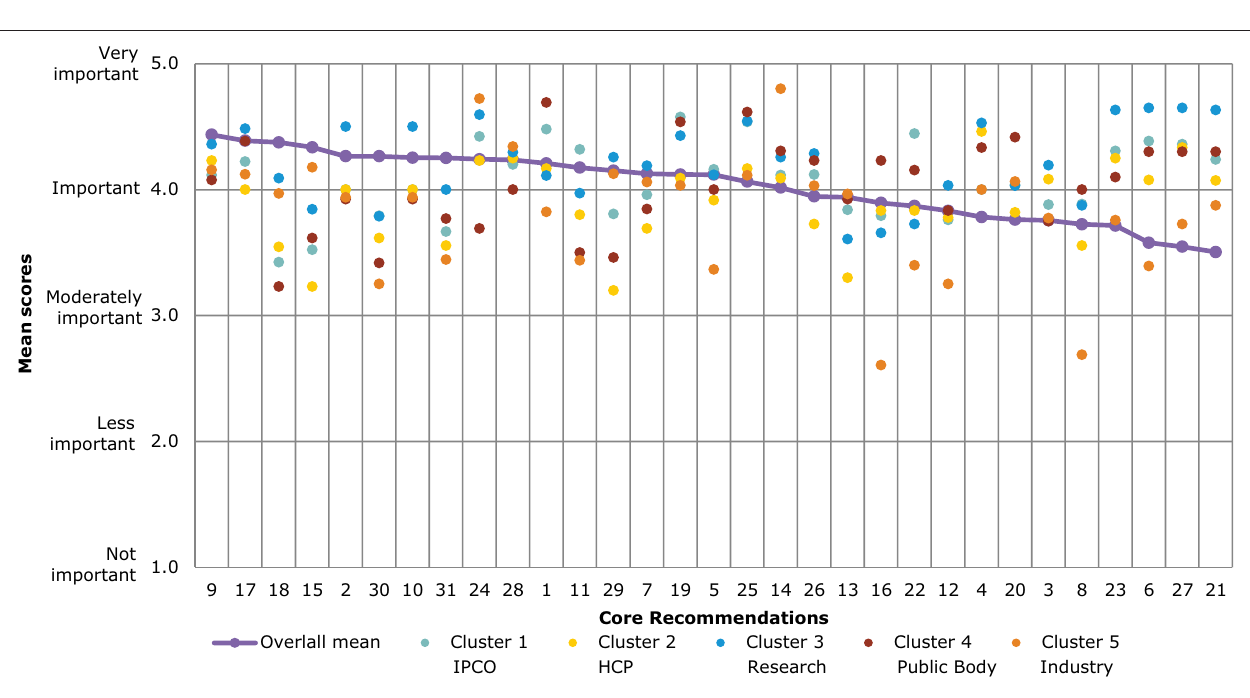
FIGURE 4 | Overall comparison of all Core Recommendations by mean score across stakeholder clusters (question 7). Overall means were calculated based on the individual scores given by participants who rated each Core Recommendation on a scale from 1 to 5: (1) not important; (2) less important; (3) moderately important; (4) important; and (5) very